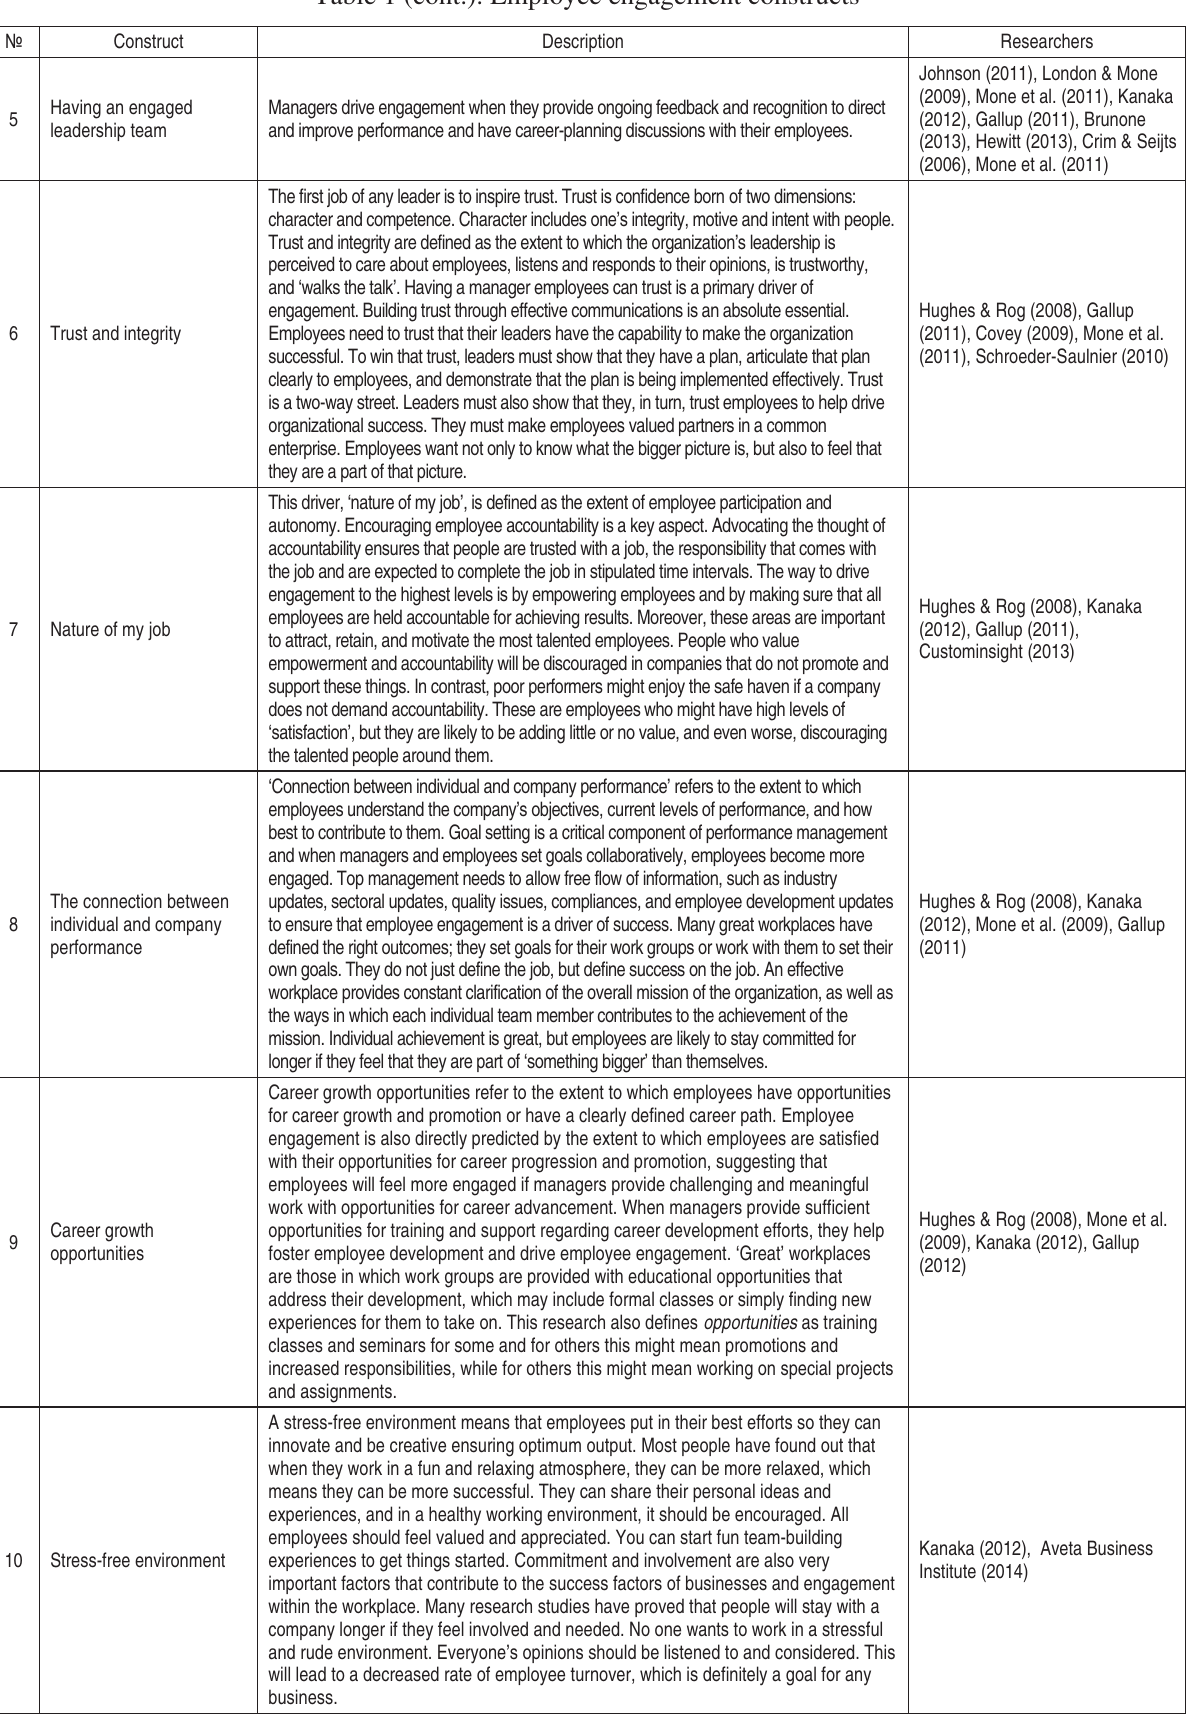
Table 1 (cont.). Employee engagement